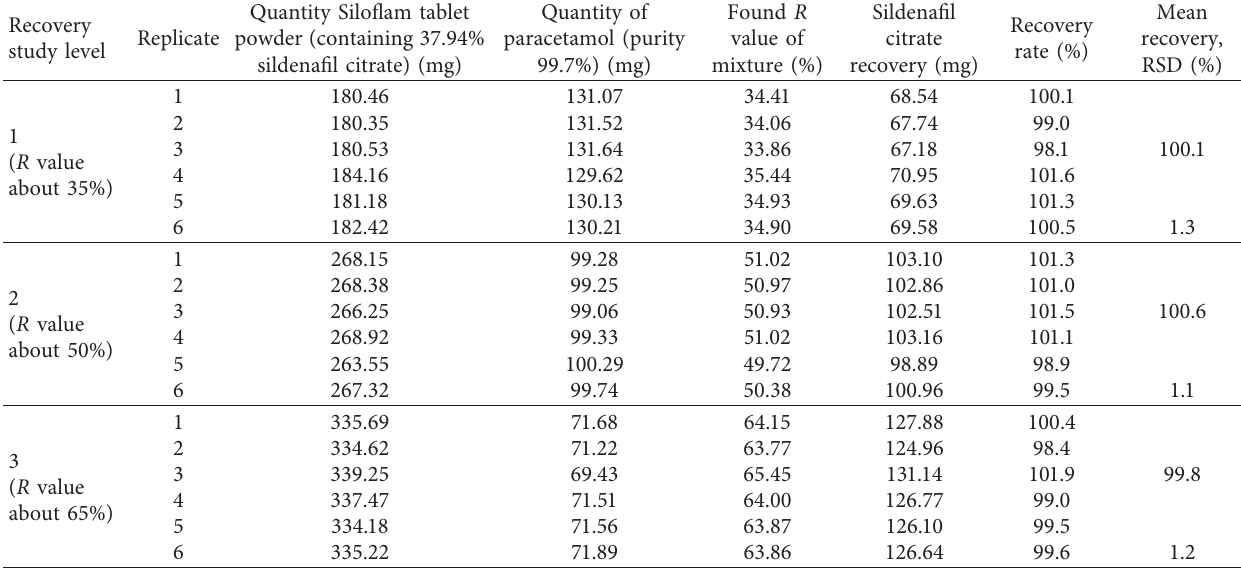
Table 2: Results of accuracy.